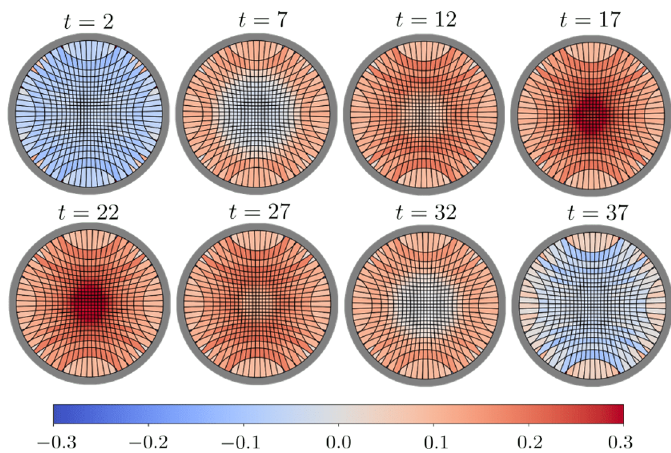
Figure 11. Quenched time dynamics of the reconstructed geometry corresponding to a global mass deformation. The boundary data is pre-processed by smoothing to remove small-scale de- tails. The dominant component h 22 is shown here. The boundary relative error is largely similar to the unsmoothed version except at the initial/final times, where it is significantly reduced by the